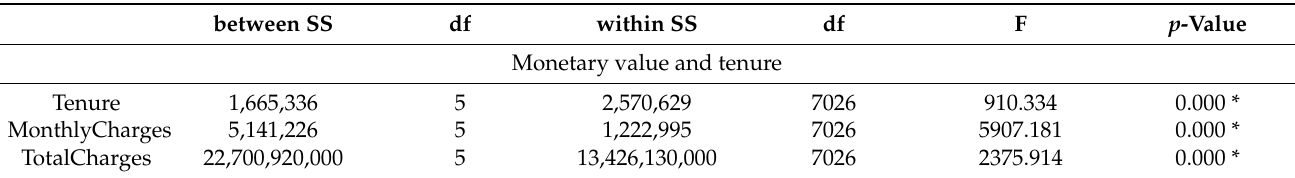
Table 2. ANOVA analysis for numeric variables.